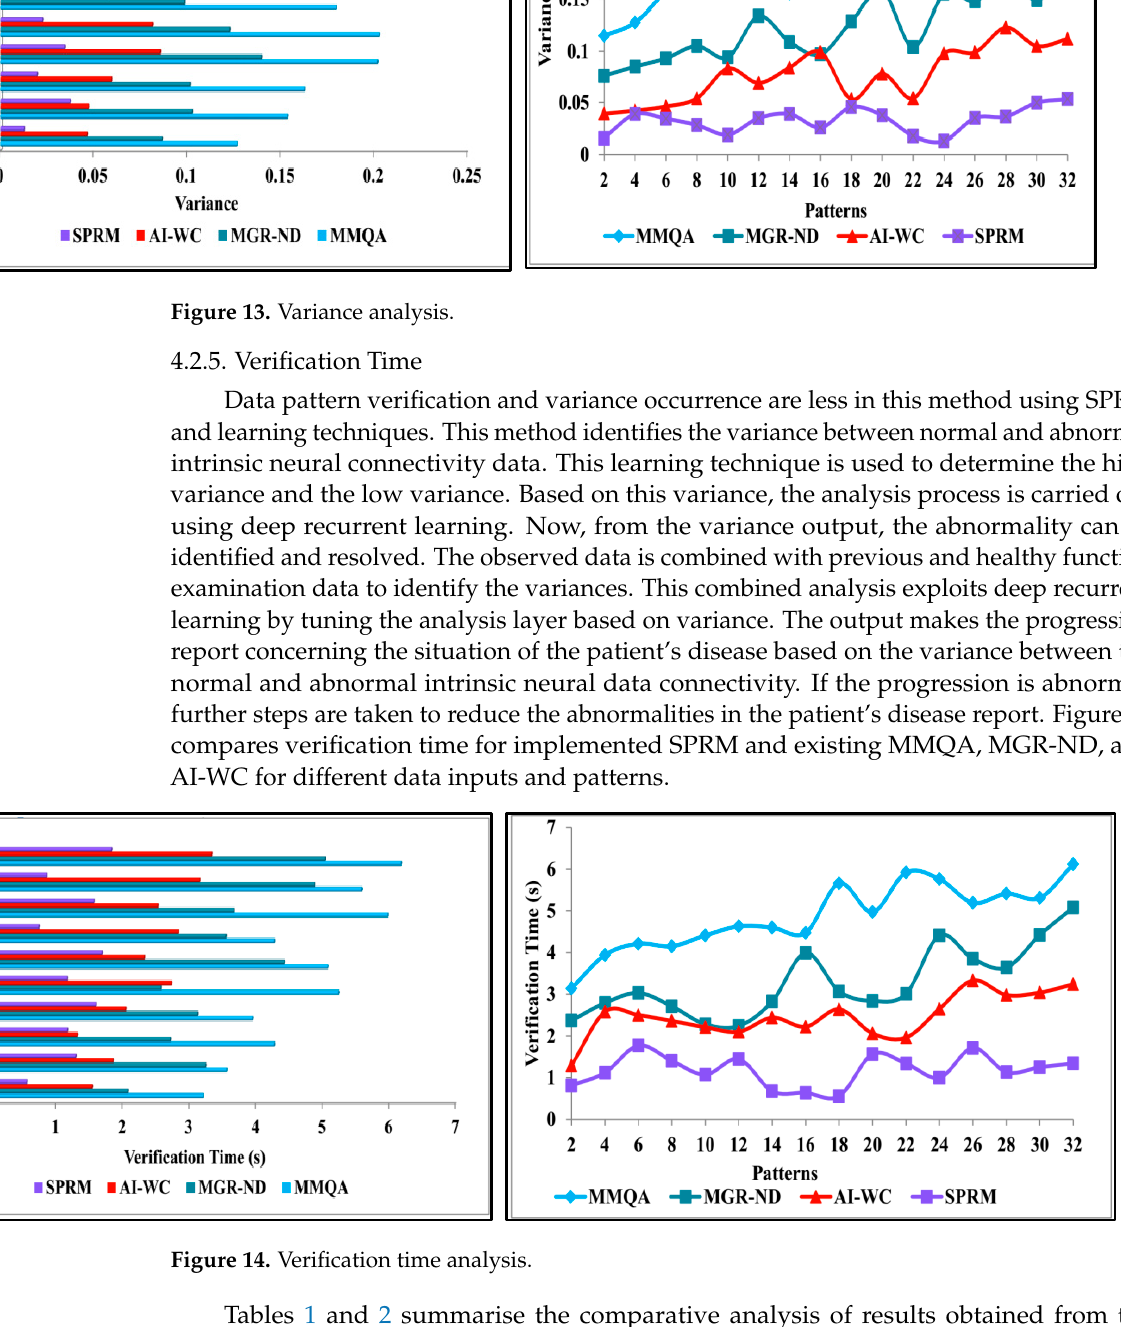
Table 1. Summary of data inputs.